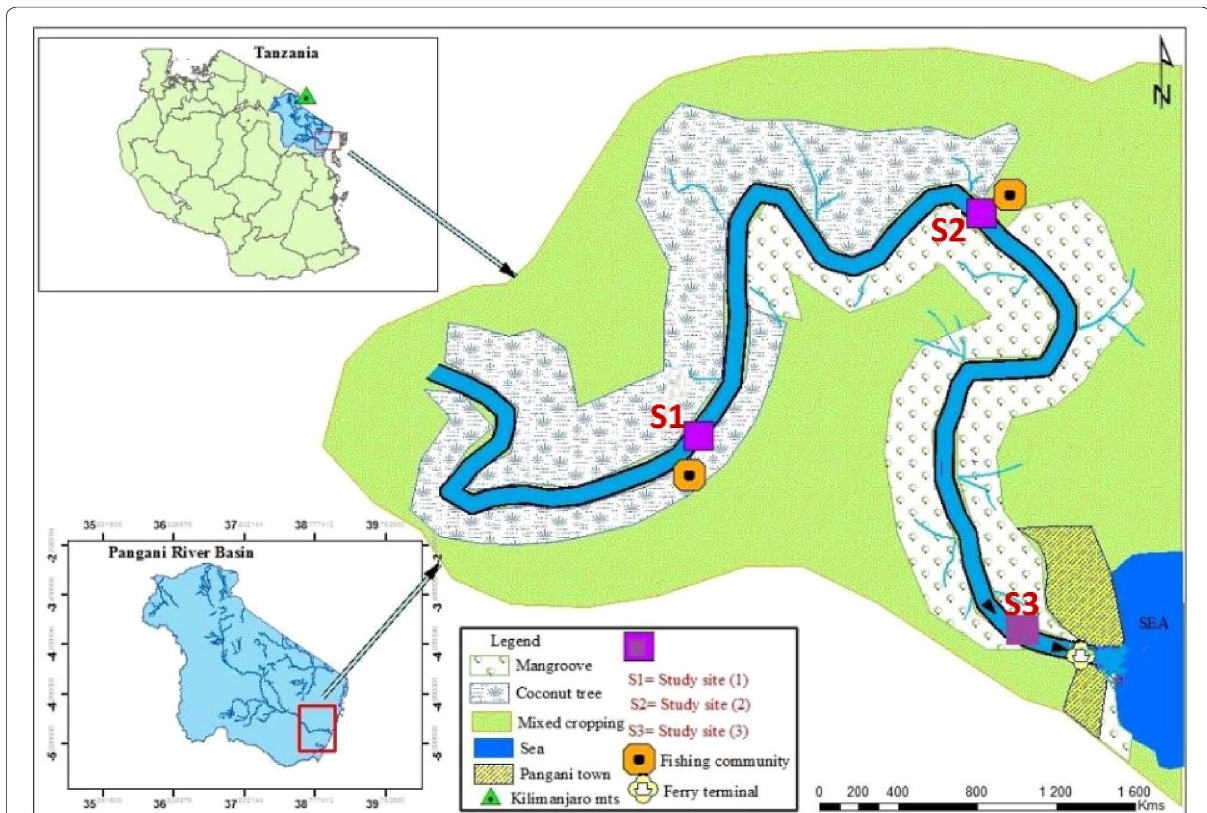
Fig. 1 Map of the the Pangani estuary showing the sampling zones. The site 1, site 2 and site 3 marks indicate the end of the upper, middle and lower sampling estuarine zones,